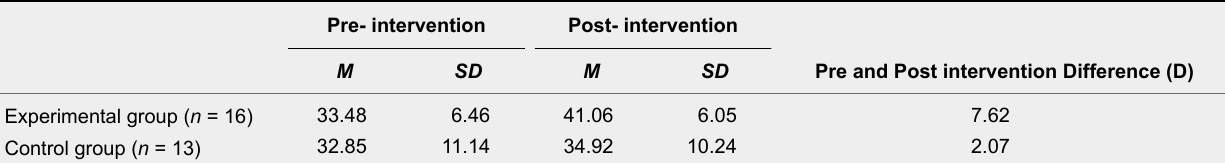
Mean and Standard Deviation of Pre-Intervention and Post-Intervention Tests Pre- intervention Post- intervention Pre and Post intervention Difference (D) M SD M SD Experimental group ( n = 16) 33.48 6.46 41.06 6.05 7.62 Control group ( n = 13) 32.85 11.14 34.92 10.24